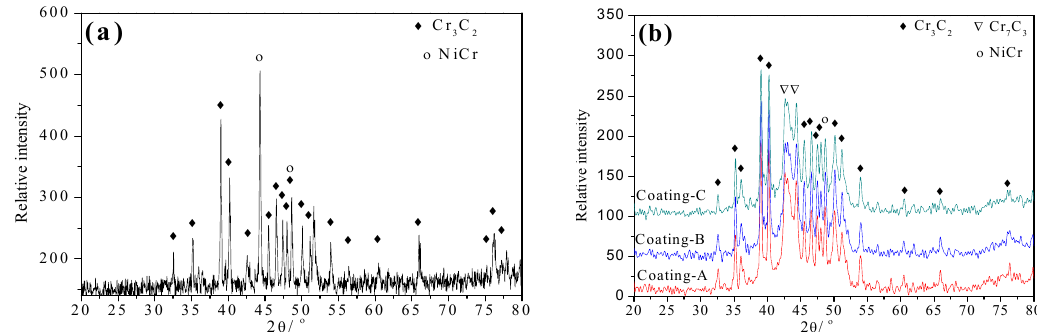
Figure 1. XRD patterns of powder and coatings: ( a ) powder, ( b ) coatings.